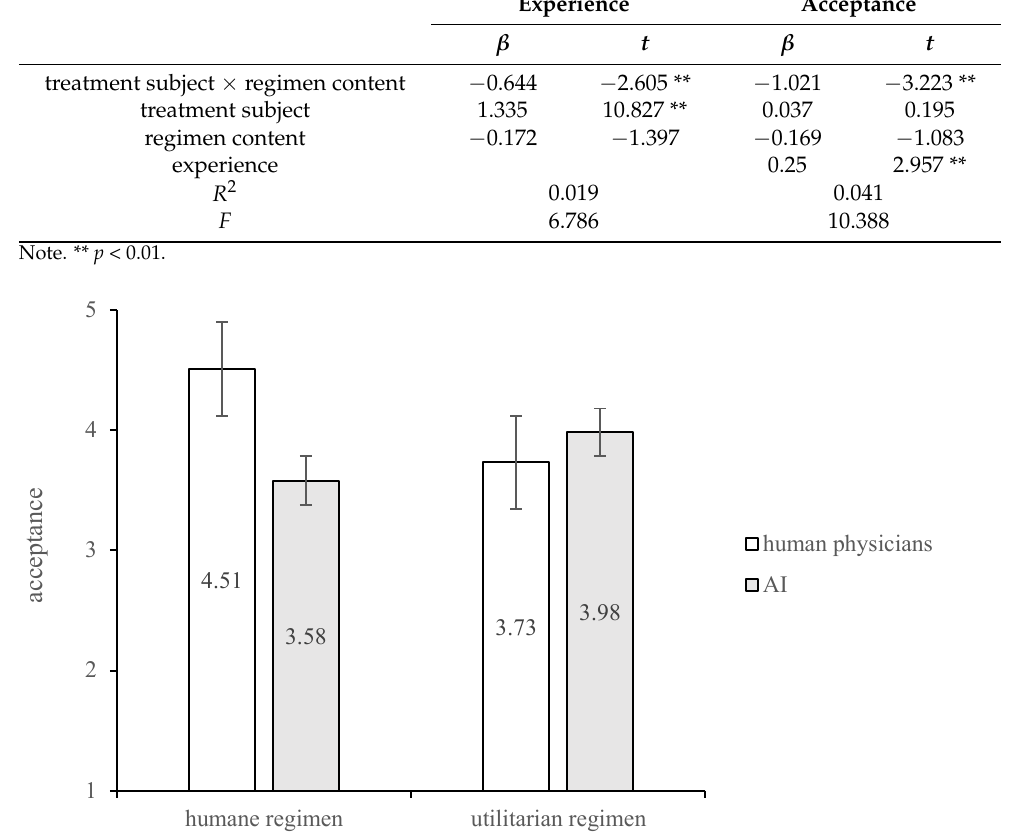
Figure 3. Interaction of Human vs. AI and the type of regimen on acceptance.